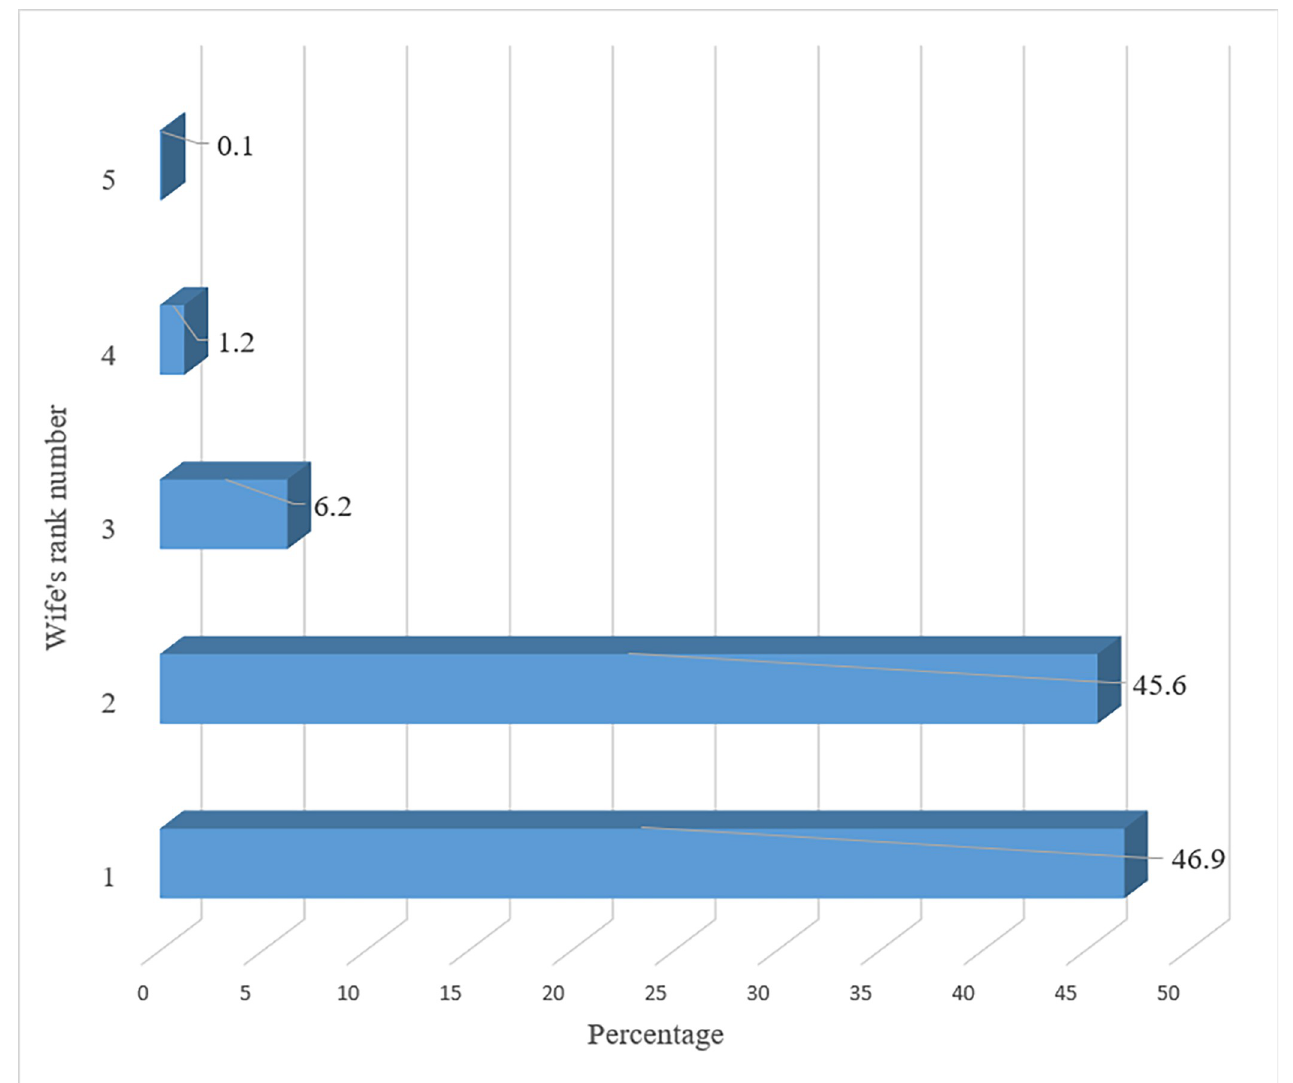
Fig 2. The rank of Christian women involved in a polygyny